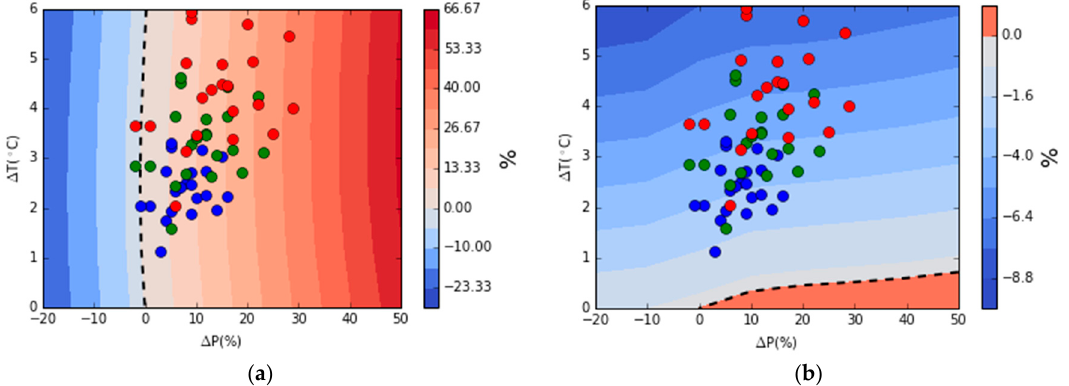
Figure 5. Climate Response Functions (CRFs) of the average annual changes (%) in: ( a ) river inflows; and ( b ) electricity consumption (obtained for W1G1 scenario) compared with control period. The dashed black curves show the “no change” edge. Dots show expected annual changes in temperature and precipitation change obtained from 23 GCM, as illustrated in Figure 2, for 2040–2059 (blue), 2060–2079 (green) and 2080–2099 (red).